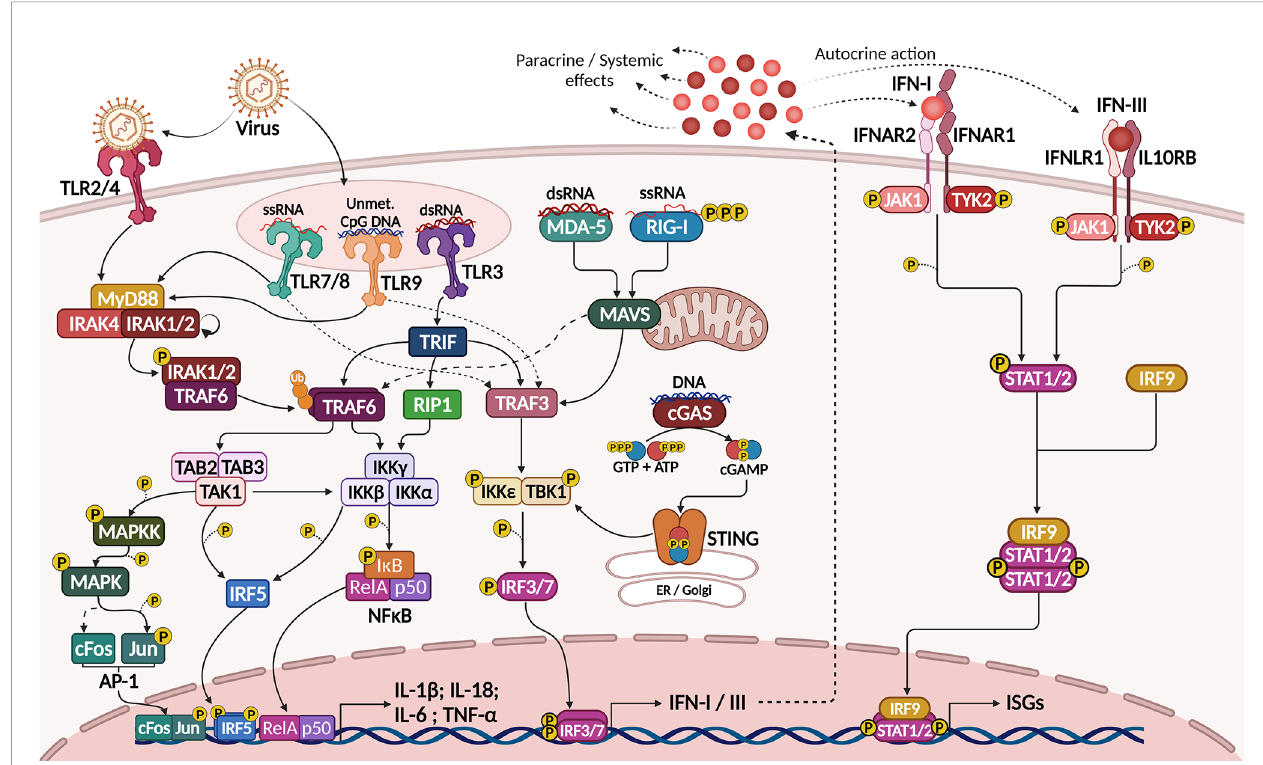
FIGURE 1 | Activation of IFN-I/III response by viral sensing through PRRs. Sensing of viral molecules by plasma membrane (TRL4), endosomal (TLR3, 7, 8 and 9) or cytosolic (RLRs and cGAS) PRRs activate signaling pathways culminating in the expression of pro-in fl ammatory cytokines (IL-1 b , IL-6, IL-18 and TNF a ) by NF- k B, AP-1 and IRF5 transcription factors and of IFN-I and IFN-III by IRF3 and IRF7 (left). IFNs act though transmembrane receptors to activate STAT1, STAT2 and IRF9. This complex then translocates to the nucleus to govern the expression of several interferon-stimulated genes (right), which mediate an antiviral state leading to cell apoptosis, cytostasis, antigen presentation and expression of viral restricting factors. Created with